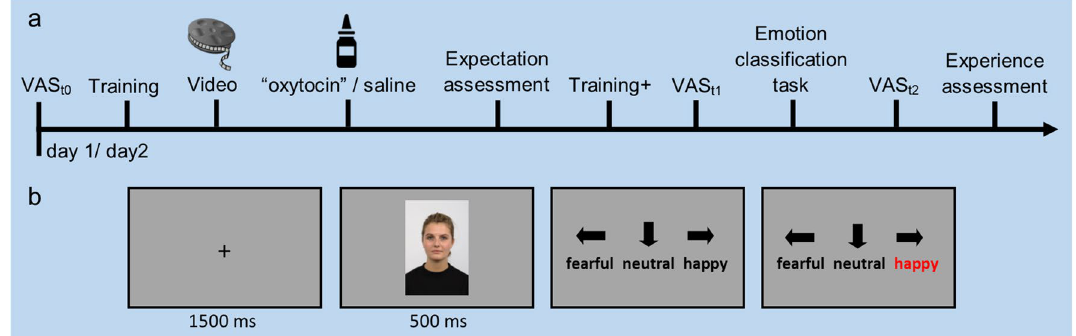
Figure 1. Study design and paradigm. ( a ) Procedure timeline. ( b ) Timing of the emotion classification paradigm. VAS = visual analogue scale. Face depicts an example stimulus used with permission from the Radboud Face